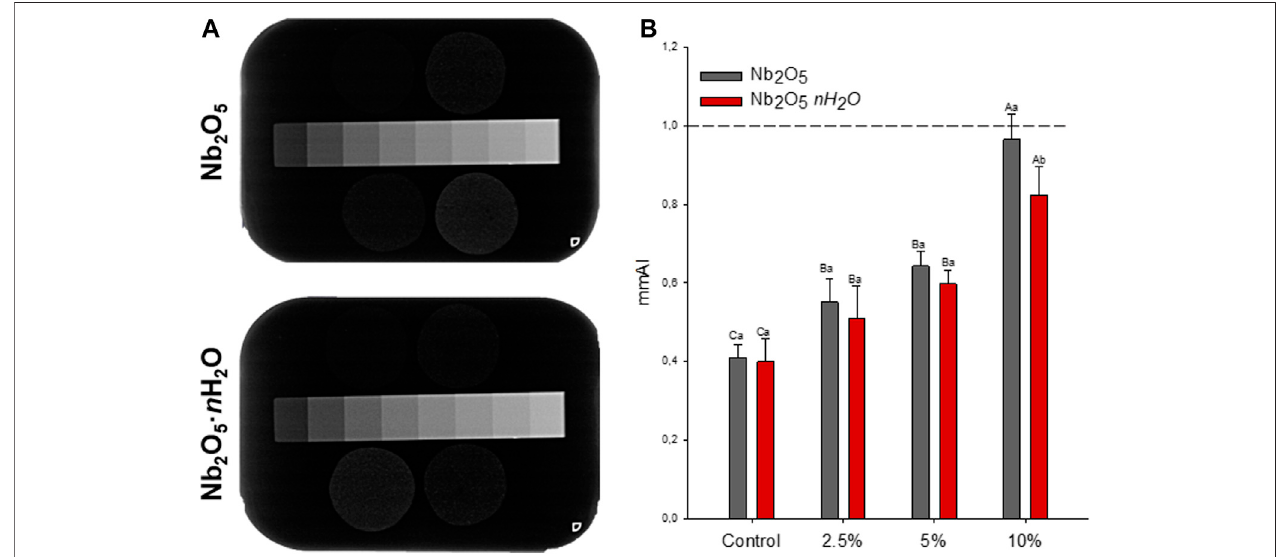
FIGURE1| Radiopacityoftheformulatesdentaladhesives (A) RepresentativeimagesofX-raysradiographsfromtheadhesiveswithdifferenttypesof fi llers(Nb 2 O 5 or Nb 2 O 5 . n H 2 O) and different concentrations (0, 2.5, 5, and 10 wt%). The aluminum scale bar was positioned close to the specimens to obtain mm Al values (B) Quanti fi cation of radiopacity inmm Al. The dotted line represents 1 mm Al, which isthe same radiopacity of 1 mm ofdentin.Differentcapital letters indicate astatistically signi fi cant difference among the concentrations (0, 2.5, 5, and 10 wt%) for the same type of fi ller (Nb 2 O 5 or Nb 2 O 5 . n H 2 O) ( p < 0.05). Different lowercase letters indicate a statistically signi fi cant differencewithin the same concentration (0, 2.5, 5, or 10 wt%) comparing the different types of fi ller (Nb 2 O 5 or Nb 2 O 5 . n H 2 O) ( p < 0.05).